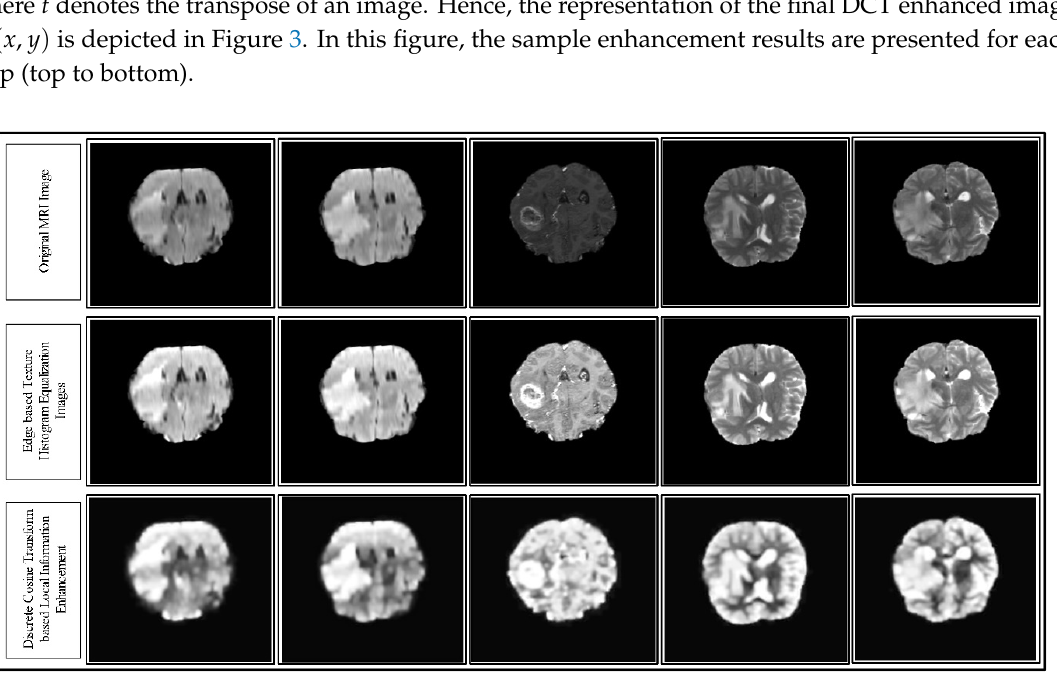
Figure 3. Results of the proposed hybrid local contrast enhancement using the MRI images of the Multimodal BRATS 2018 dataset. The results are shown from top to bottom.